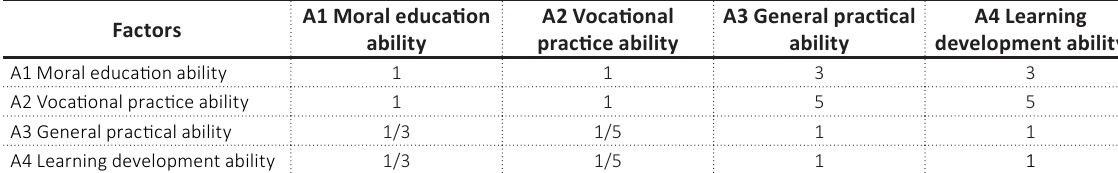
Table 3. Primary indexes of expert judgment